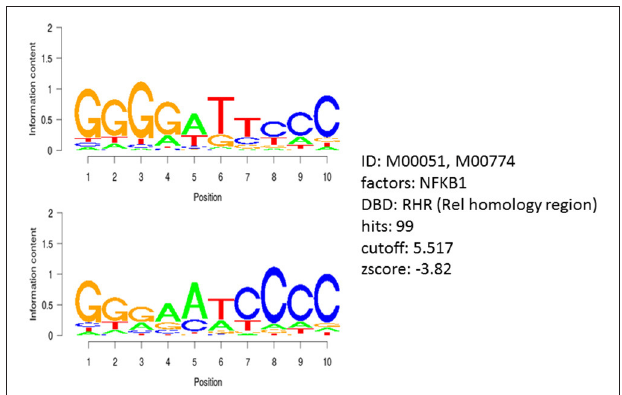
FIGURE 5 | Motif analysis of 25kb upstream regions of 40 genes identified by COMPARE analysis revealing the significant presence of NF- κ B binding motif.